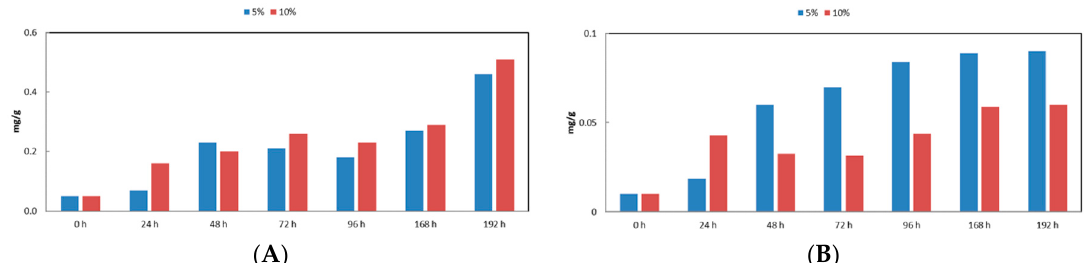
Figure 3. Carotenoid content of C. sorokiniana cultures prepared with MSN at different concentrations. Microalgae cultures were incubated with media obtained by extraction of wine residues (MSN) at 5% and 10%. Both cultures were inoculated with 25 µg Chl/mL, with 100 µmol of photons/m 2 /s of white light, incubated at a temperature of 25 °C and were fluidized with air enriched in CO 2 (5% v / v ). Content of lutein ( A ) and β -carotene ( B ), expressed in mg/g, were calculated by HPLC throughout the experiment (192 h) as indicated in Materials and Methods section.